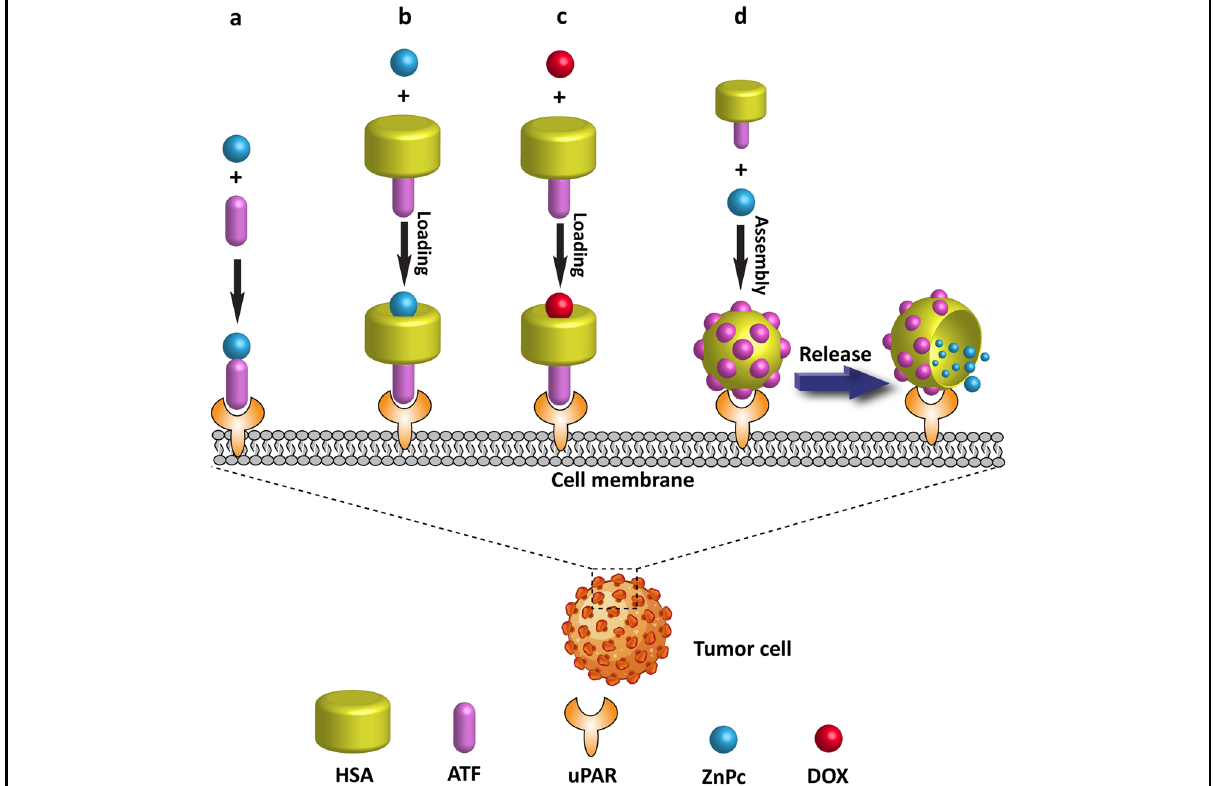
Fig. 2 Development of therapeutics targeting uPAR. UPAR has been certi fi ed to be overexpressed on tumor cell surfaces. We developed a series of uPAR-targeting therapeutics. a ATF-ZnPc conjugate: a ZnPc-based photosensitizer was covalently conjugated with the uPAR-binding fragment of uPA (ATF). b , c Recombinant ATF-HSA, which integrates the uPAR-targeting property and the drug-loading property of HSA, delivered ZnPc ( b ) or doxorubicin (DOX, c ) to tumor sites. d A uPAR-targeting drug carrier, developed by using ATF-HSA nanoparticles, encapsulated and released loaded ZnPc on the tumor